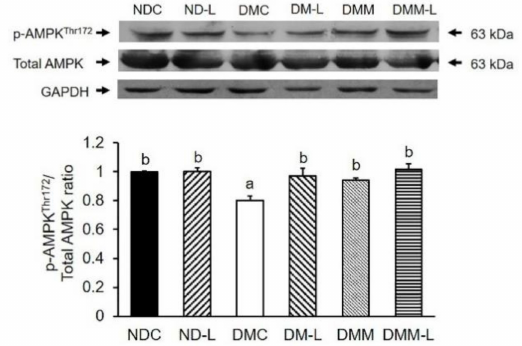
Figure 4. E ff ects of L. paracasei HII01 on Western blotting of pAMPK Thr172 / Total AMPK ratio in skeletal muscle of experimental groups. NDC, normal control rats; ND-L, normal control rats supplemented with L. paracasei HII01 (10 8 CFU / day); DMC, diabetic rats control; DM-L, diabetic rats supplemented with L. paracasei HII01 (10 8 CFU / day); DMM, diabetic rats treated with metformin 30 mg / kg; DMM-L, diabetic rats supplemented with combination of L. paracasei HII01 (10 8 CFU / day) and metformin 30 mg / kg. pAMPK Thr172 / total AMPK ratio, phosphorylation of AMP-activated protein kinase per total AMPK ratio. All data are expressed as mean ± SEM. Di ff erent lowercase letters indicate significant di ff erences among di ff erent groups ( p <